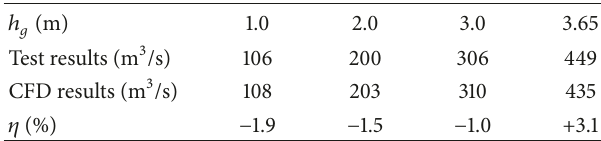
Table3:Comparisonofthe 𝑄 𝑤 resultsbetweenthe2008modeltests and